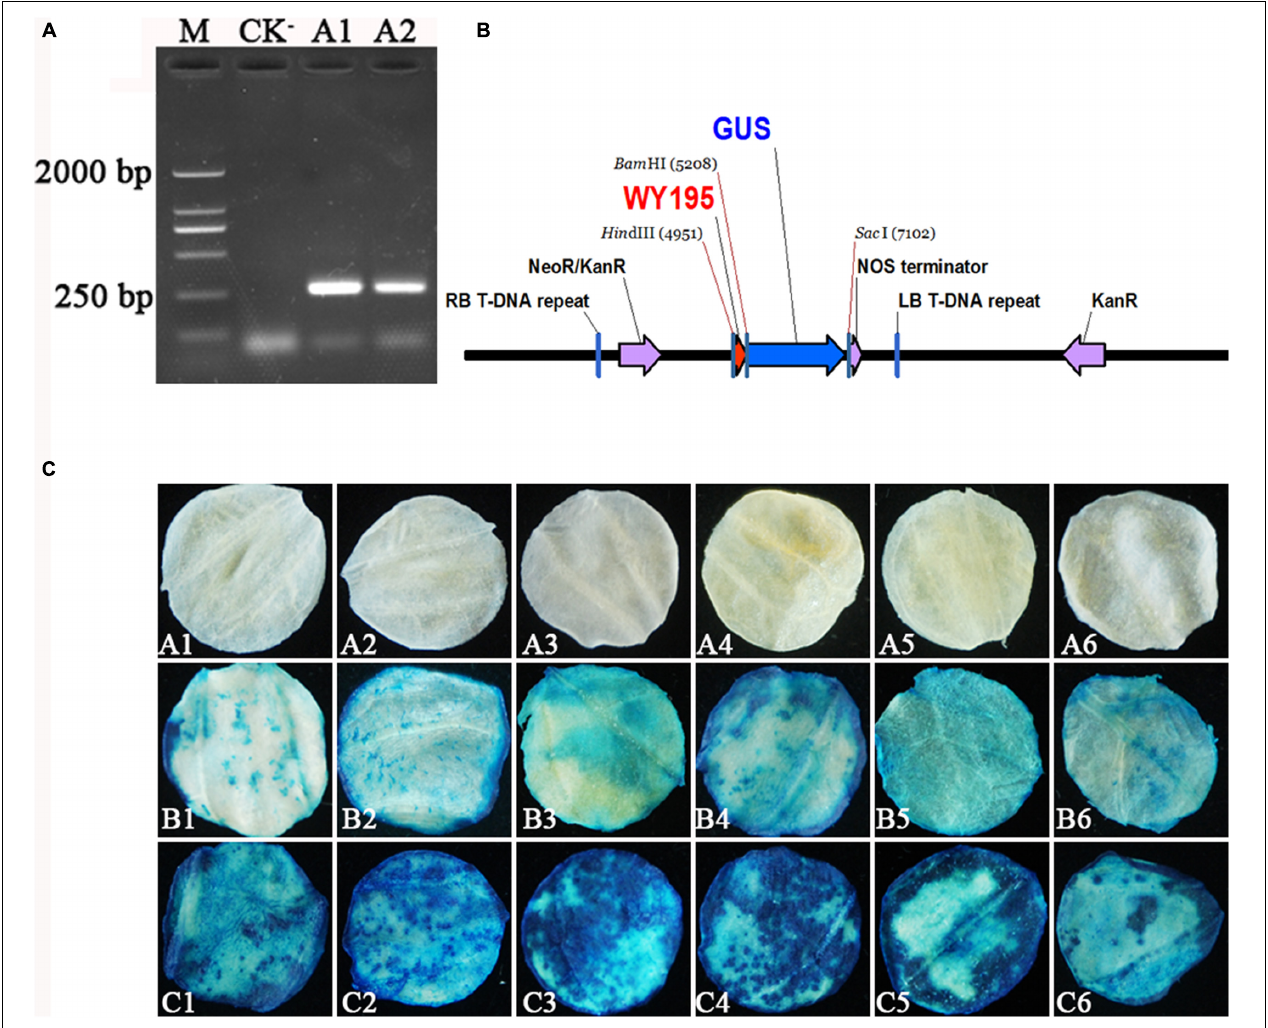
FIGURE 1 | Verification of WY195 promoter function. (A) Amplification of WY195. (M) Marker 2000; (CK − ) Negative control with ddH 2 O as template; (A1) and (A2) WY195. (B) Map of recombinant plant expression vector pBI121-WY195. (C) Histochemical staining for GUS activity in transiently transformed leaf discs of N. tabacum . (A1–A6) CK − , negative control, leaf discs of N. tabacum wild type; (B1–B6) CK + , positive control, GUS activity in leaf discs regulated by the 35S promoter; (C1–C6) GUS activity in leaf discs regulated by the WY195